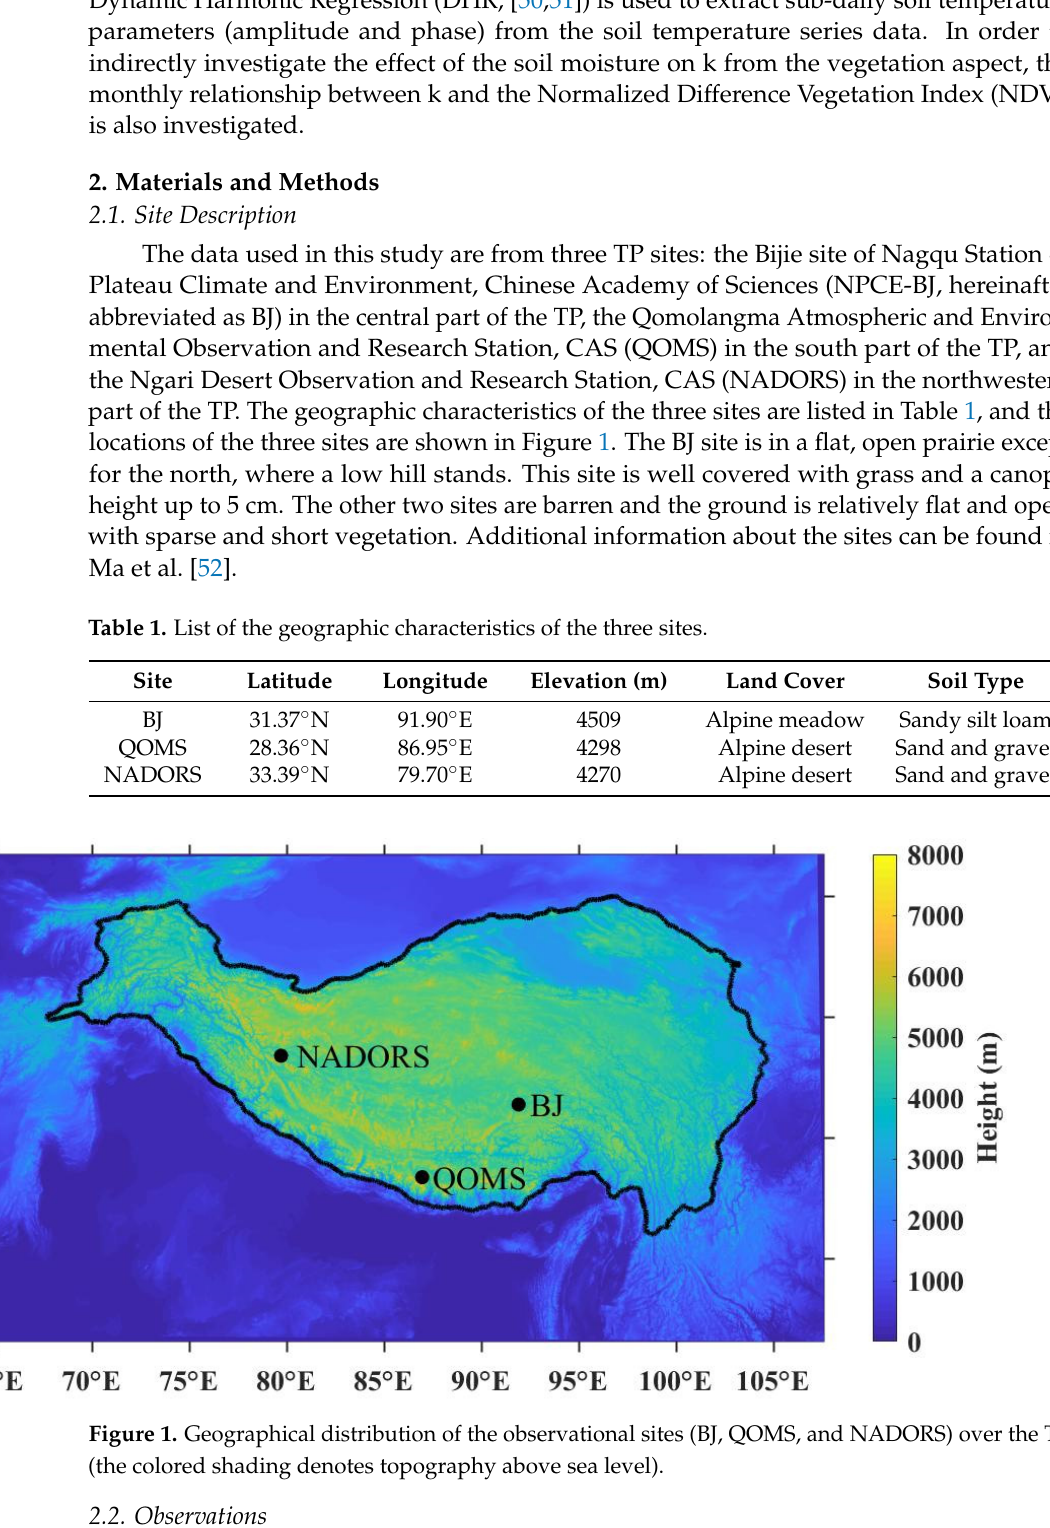
Figure 1. Geographical distribution of the observational sites (BJ, QOMS, and NADORS) over the TP (the colored shading denotes topography above sea level). Table 1. List of the geographic characteristics of the three